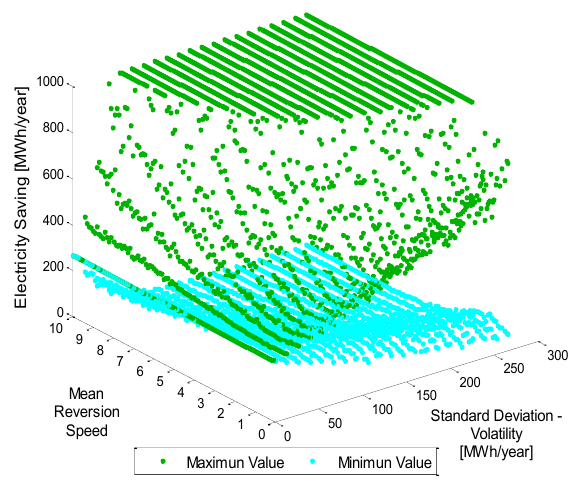
Fig. 5. Amplitude of electricity saving by variation of σ and